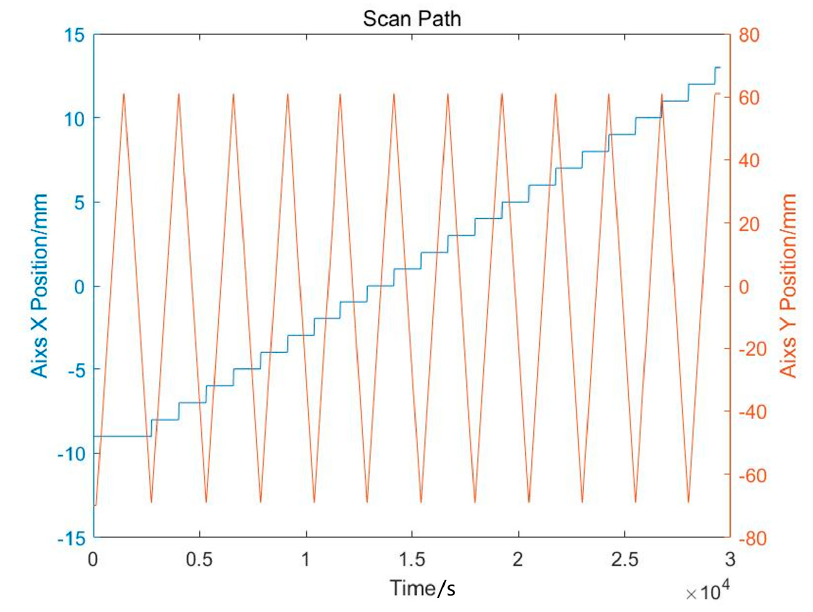
Figure 2. Moving path of the platform in X/Y plane.